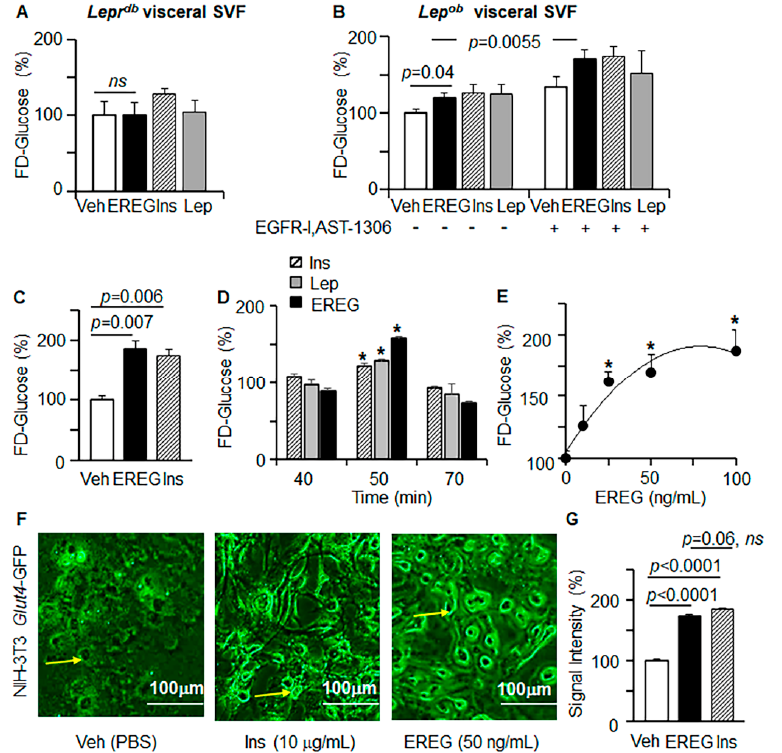
Figure 3. EREG ‐ stimulated glucose uptake was dependent on LepR but independent of EGFR. ( A,B ) Fluorescently ‐ labelled (FD) glucose uptake was measured in stromal vascular fraction (SVF) cells isolated from visceral tissues of Lepr db ( A ) or Lep ob mice ( B ). Cells were treated with either Veh (PBS), mouse EREG (50 ng/mL), human insulin (Ins, 10 μ g/mL), or mouse leptin (Lep, 200 ng/mL) for 80 min. For inhibition experiment, Lep ob SVF cells were pre ‐ treated with EGFR inhibitor (EGFR ‐ I, AST ‐ 1306, 10 μ M) or vehicle (Veh, DMSO) for 40 min. Data are shown as a percentage of Veh ‐ treated control (100%, n = 8 per treatment). Unpaired Student’s t ‐ test. ( C – E ) FD ‐ glucose uptake was measured in mouse 3T3 ‐ L3 preadipocytes. ( C ) Preadipocytes were treated with vehicle, human insulin (Ins, 10 μ g/mL), and mouse EREG (50 ng/mL) for 30 min (mean ± SEM, n = 6, t ‐ test). ( D ) Time ‐ dependent uptake of FD ‐ glucose in 3T3 ‐ L1 preadipocytes stimulated with human insulin (Ins, 10 μ g/mL), mouse leptin (Lep, 200 ng/mL), and mouse EREG (50 ng/mL). Data are shown (mean ± SEM, n = 8, t ‐ test) as % of glucose uptake compared to control cells at the same time point (Veh, 100%). ( E ) Concentration ‐ dependent increase in FD ‐ glucose uptake by 3T3 ‐ L1 preadipocytes stimulated with different concentrations of mouse EREG. Data are shown as a percentage of Veh ‐ treated control (100%, n = 6 per concentration). * p < 0.05, significant differences compared to the vehicle group, one ‐ way ANOVA). ( F ) NIH ‐ 3T3 preadipocytes were transiently transfected with pB ‐ Glut4 ‐ 7myc ‐ GFP and stimulated with vehicle, Ins (10 μ g/mL), EREG (50 ng/mL) for 60 min. Data show representative fluorescent images of GFP ‐ labeled GLUT4 selected from three independent experiments. 10× magnification. Yellow arrow shows GFP ‐ labeled GLUT4 that was translocated to the cellular membrane. ( G ) Quantification of GFP was performed in adipocytes of similar size ( n = 10) in each group.